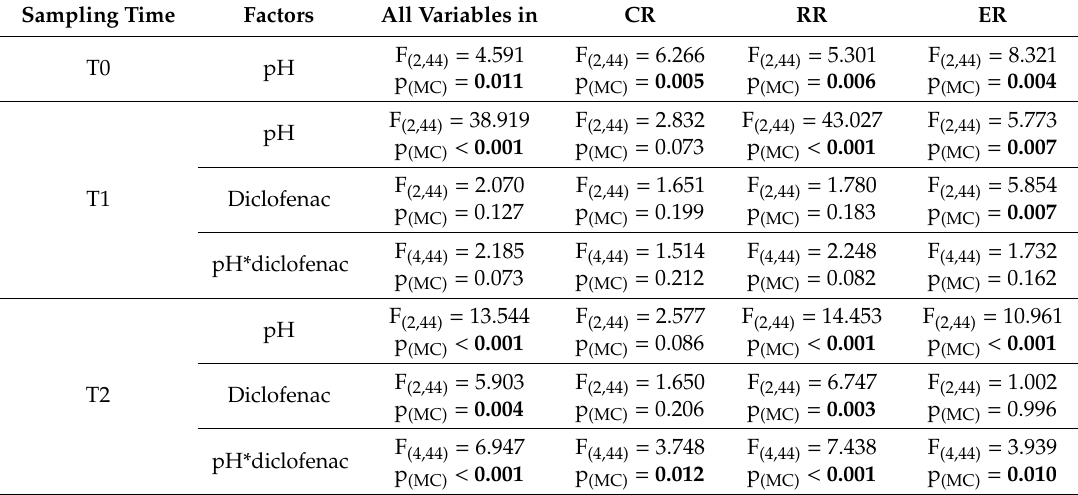
Table 2. Permutational Multivariate Analysis of Variance (PERMANOVA) results. Pseudo-F values (indicated as F) and Monte Carlo p -values for all physiological parameters and for each single parameter measured in Mytilus galloprovincialis throughout the experiment performed at three pH levels (pH N, pH − 0.4, and pH − 0.7), in the absence (T0: 7-days exposure) or in the presence of 0.05 and 0.50 µ g / L